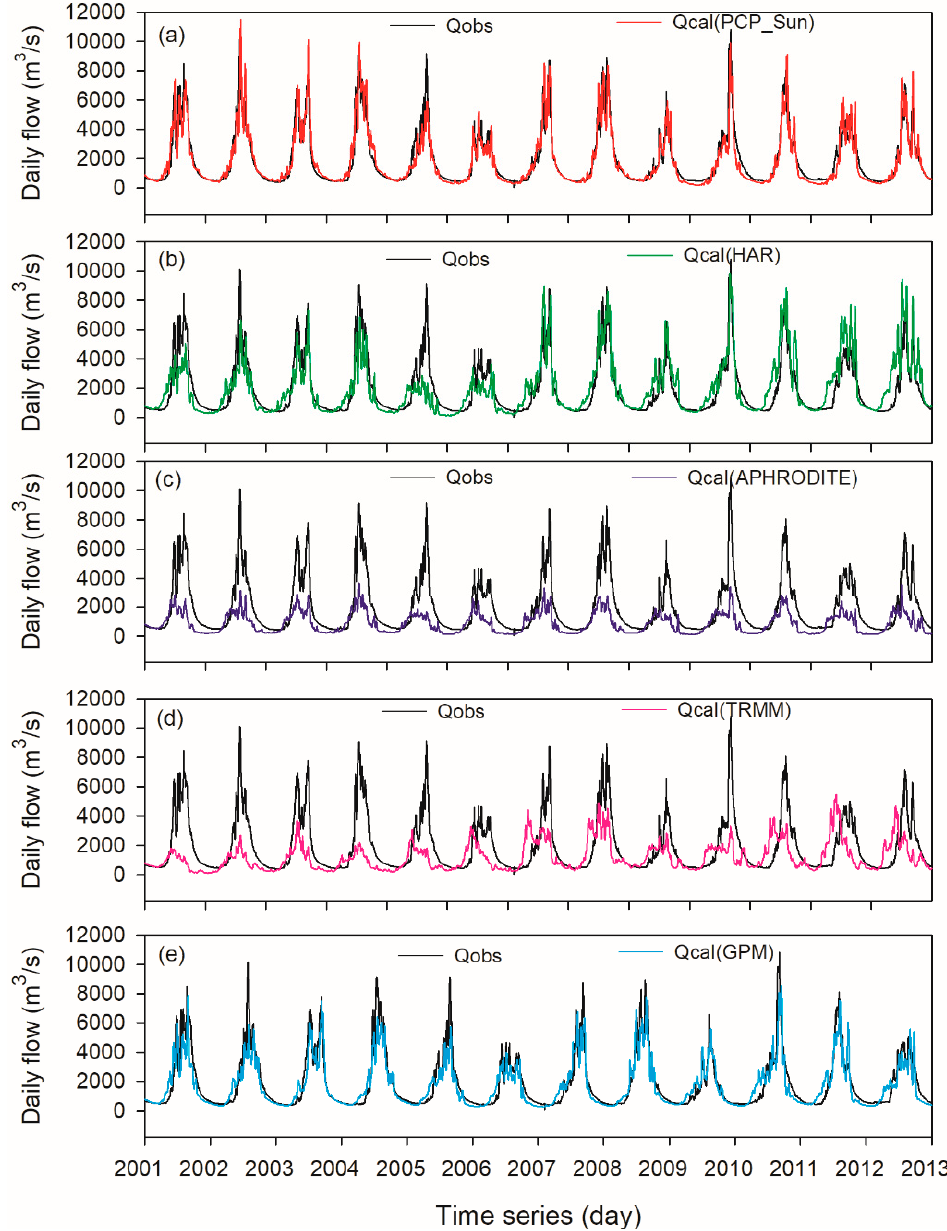
Figure 7. Daily flow simulation driven by ( a ) reference precipitationand four precipitation datasets: ( b ) HAR, ( c ) APHRODITE, ( d ) TRMM and ( e ) GPM, at Nuxia hydrological station during years 2001–2013. Qobs represents the observed streamflow. Qcal(PCP_Sun), Qcal(HAR), Qcal(APHRODITE), Qcal(TRMM) and Qcal(GPM) represent the calculated streamflow using the corresponding individual precipitation dataset.